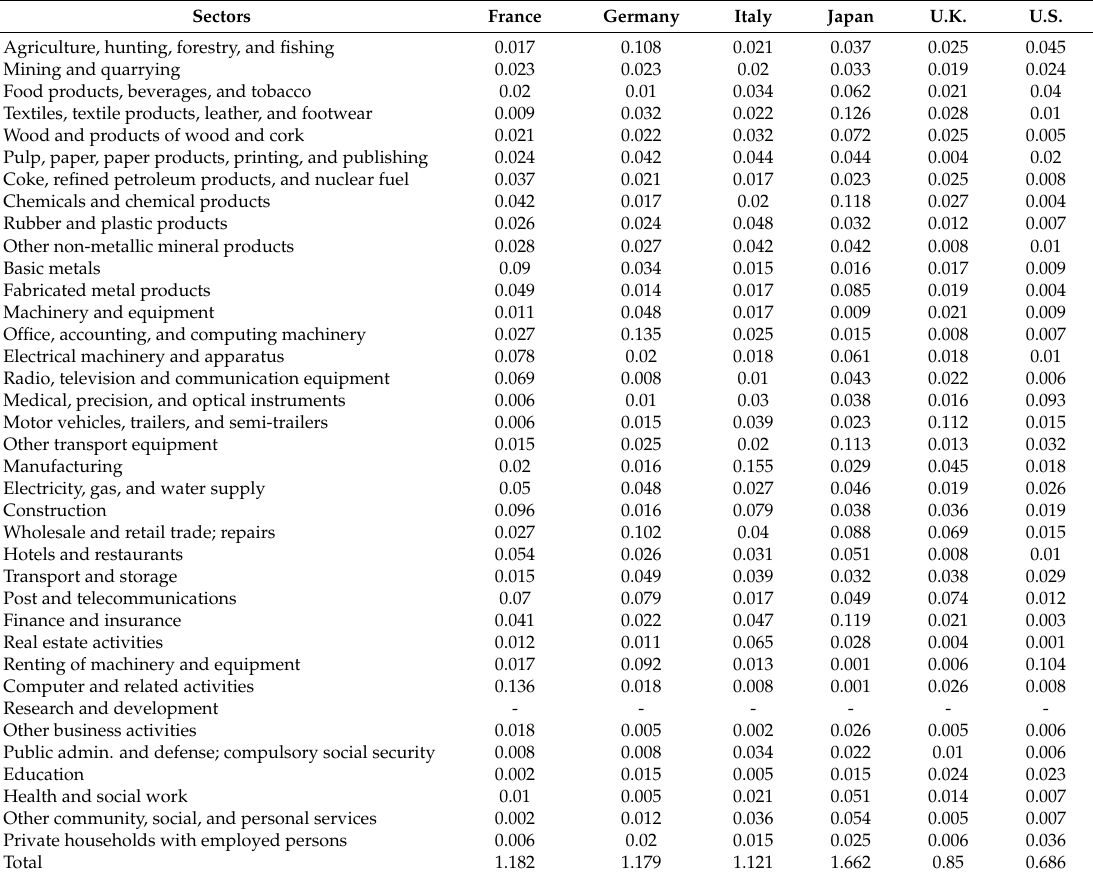
Table 3. Supply Investment Effects of R&D Sector in Major OECD Countries.